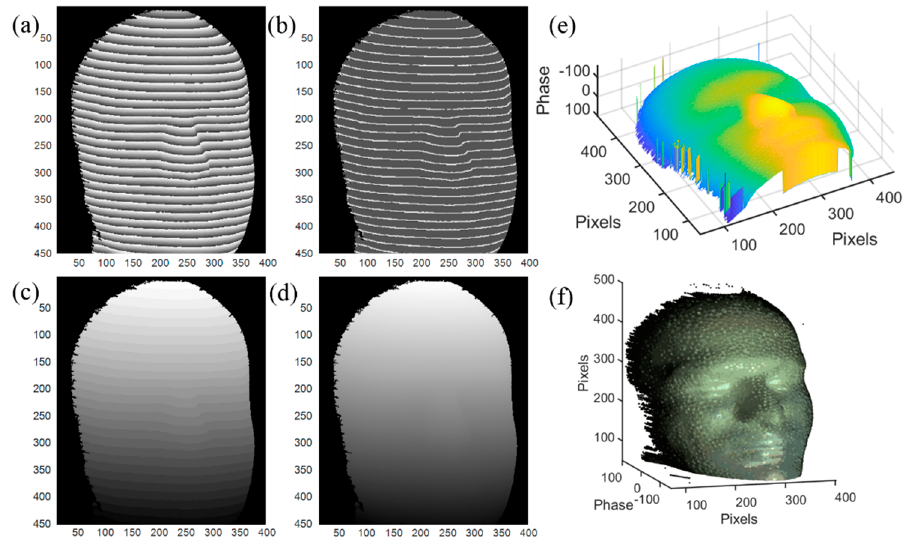
Figure 10. Phase unwrapping and 3D reconstruction of a human head model with thinner sinusoidal stripes. ( a ) Input wrapped phase data; ( b ) output phase feature map, ( c ) output phase feature map with assigned integer to each segment, ( d ) unwrapped phase, ( e ) 3D construction image of the target, and ( f ) 3D image of the target with color information.